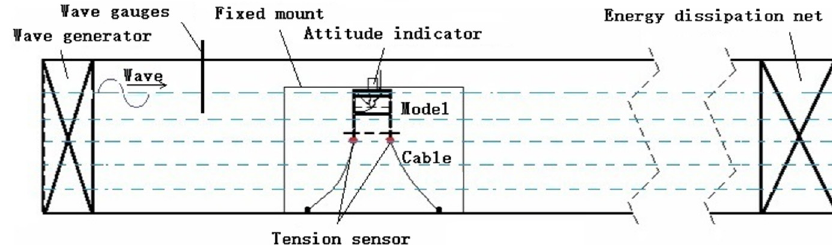
Figure 9. Model’s installation location.